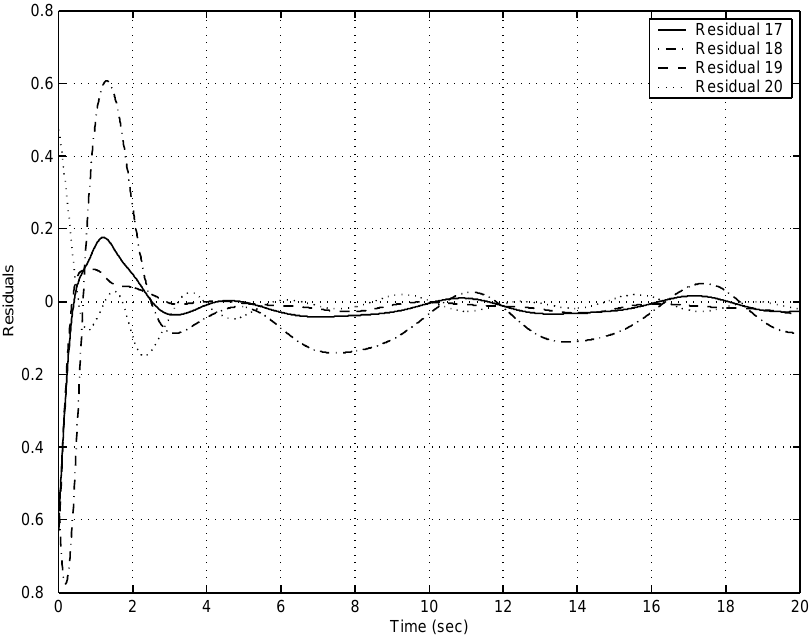
Fig. 20. Residuals 17–20 for 16 mode simulation with δ 1 = 0 . 01